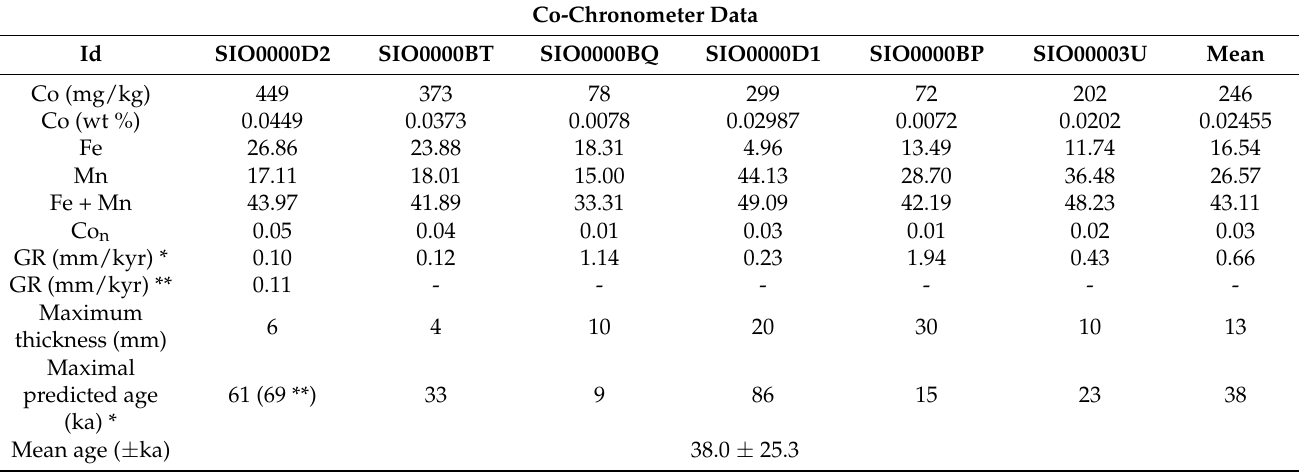
Table 5. Estimation of growth rates and crusts formation age using Co-chronometer method (after